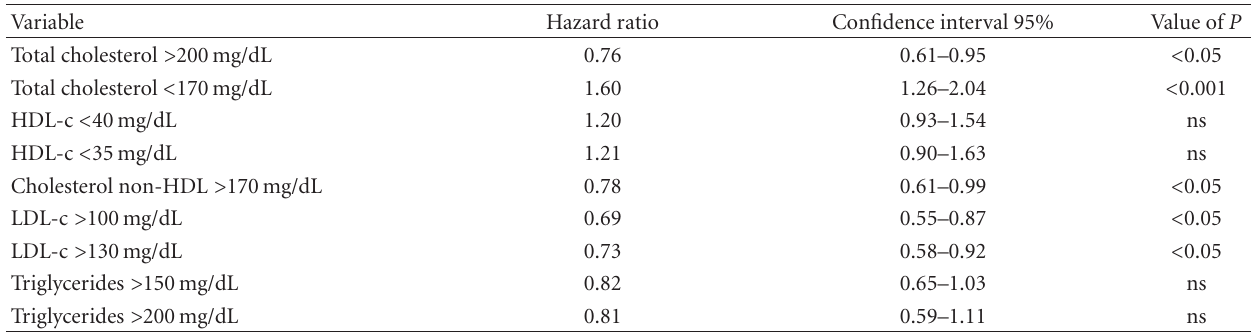
Table 2: All-cause mortality risk and lipid levels in adjusted by sex, age > 75, hypertension, and